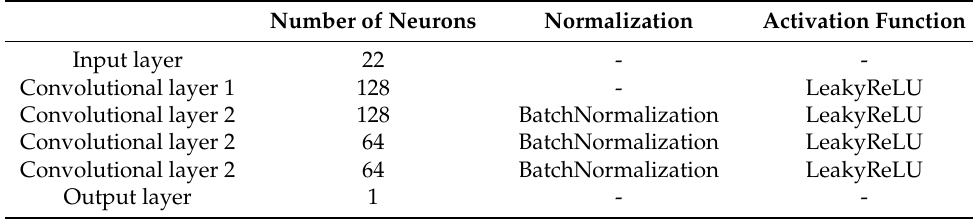
Table 3. Structure of